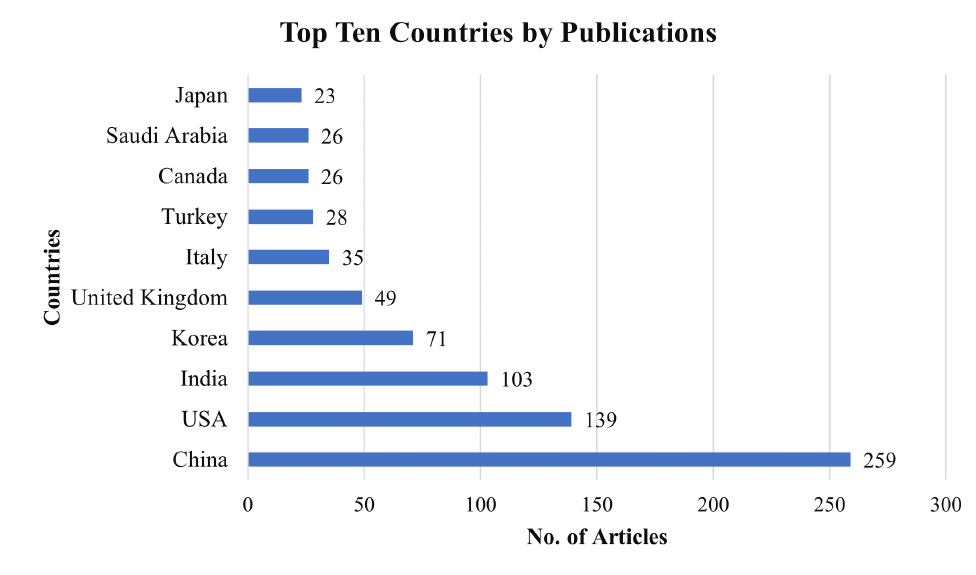
Figure 9. Top ten countries that contributed to MLBDD literature.